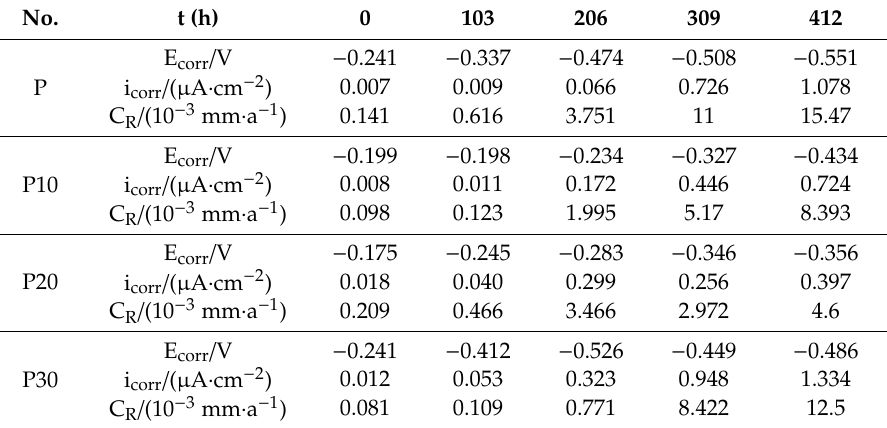
Table 5. Electrochemical parameters of the polarization